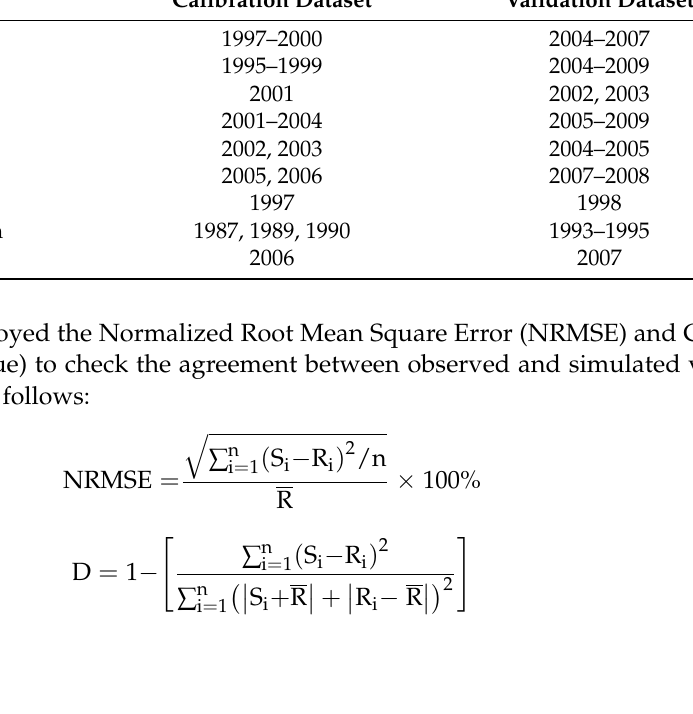
Table 2. Experimental dataset for CERES-Wheat calibration and validation at nine stations.